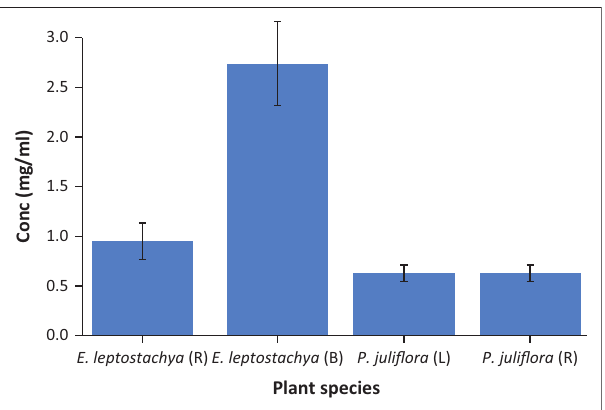
FIGURE 4: Bar graph indicating the concentration of total phenols (mg/g) in E. leptostachya and P. juliflora extracts.